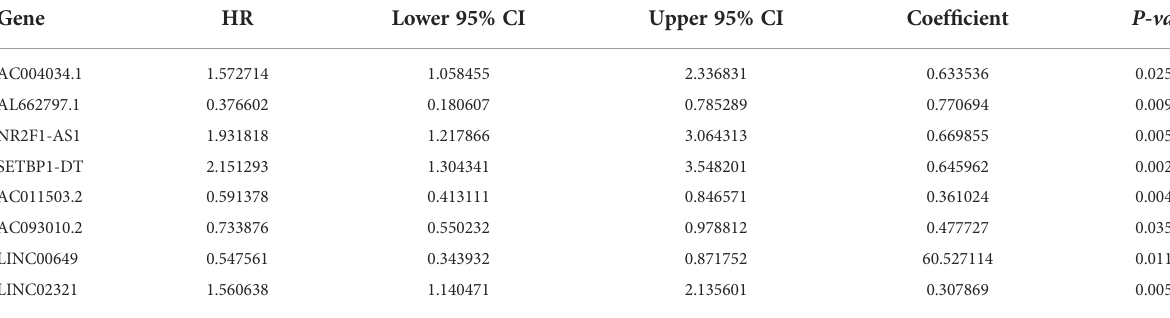
TABLE 1 Eight DEBMlncRNAs with BCa in the TCGA dataset were identi fi ed by LASSO